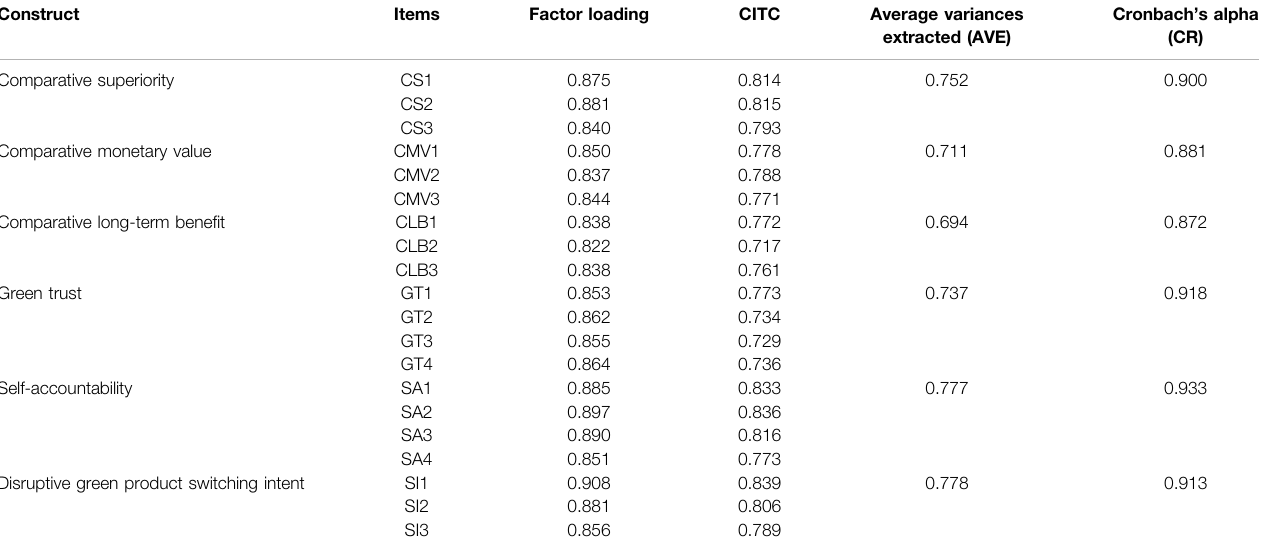
TABLE 4 | Constructs, items, and measurement model ( N (cid:1) 317). Construct Items